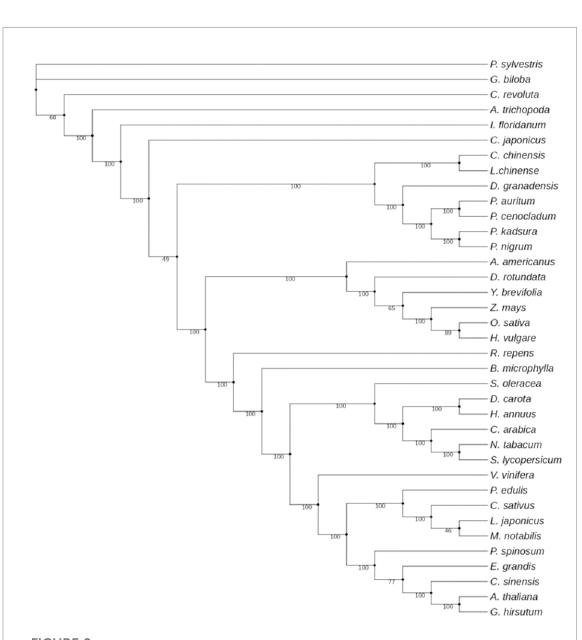
FIGURE 9 Phylogenetic tree of 37 different species based on 58 protein- coding